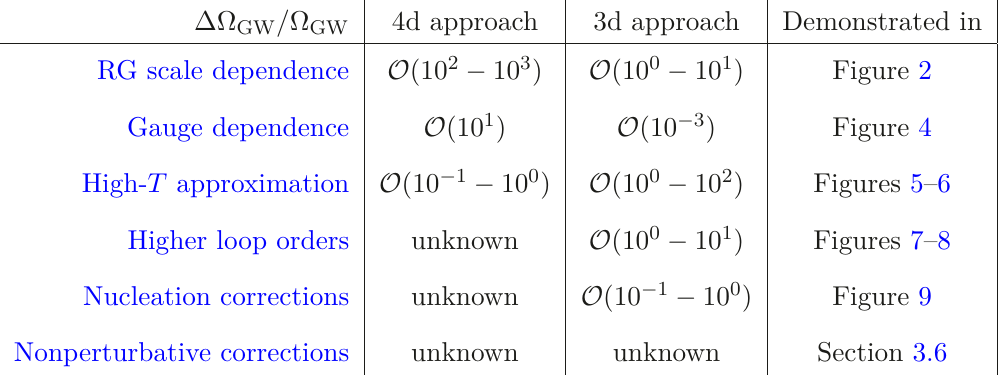
580 700 GeV in the SMEFT. Although we { − }